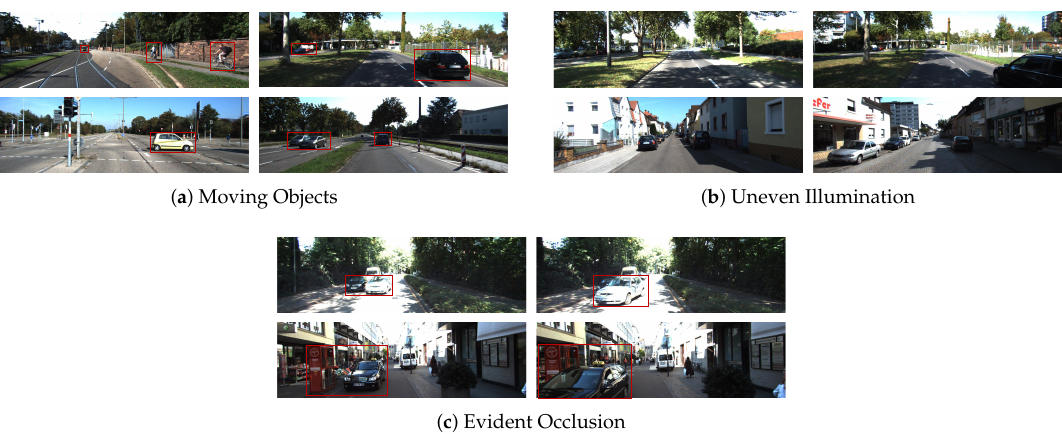
Figure 4. The challenging scenes in KITTI dataset: ( a ) the moving objects scene. The red boxes represent moving objects; ( b ) the uneven illumination scene; ( c ) the evident occlusion scene. The red boxes represent the object being